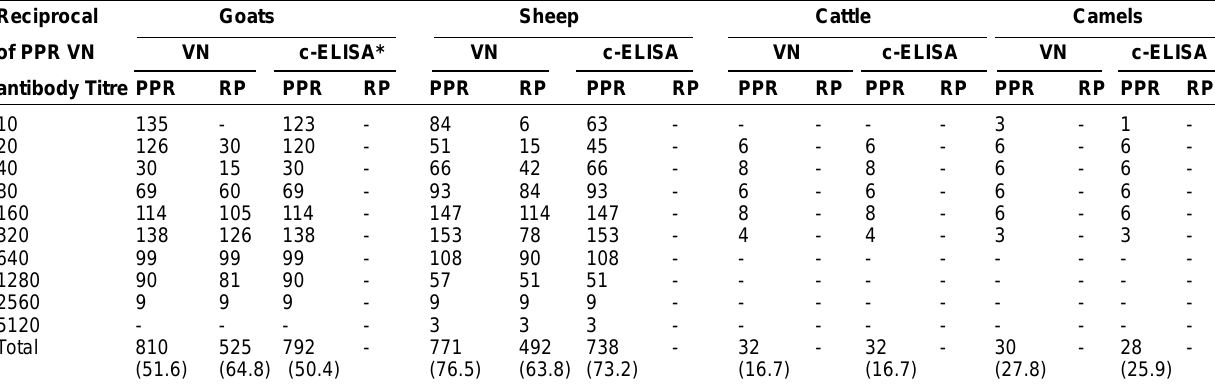
Table-2. Results of VN test and c-ELISA in differentiating PPR from RP antibodies in the sera of some ruminants in the semi- arid region of NE